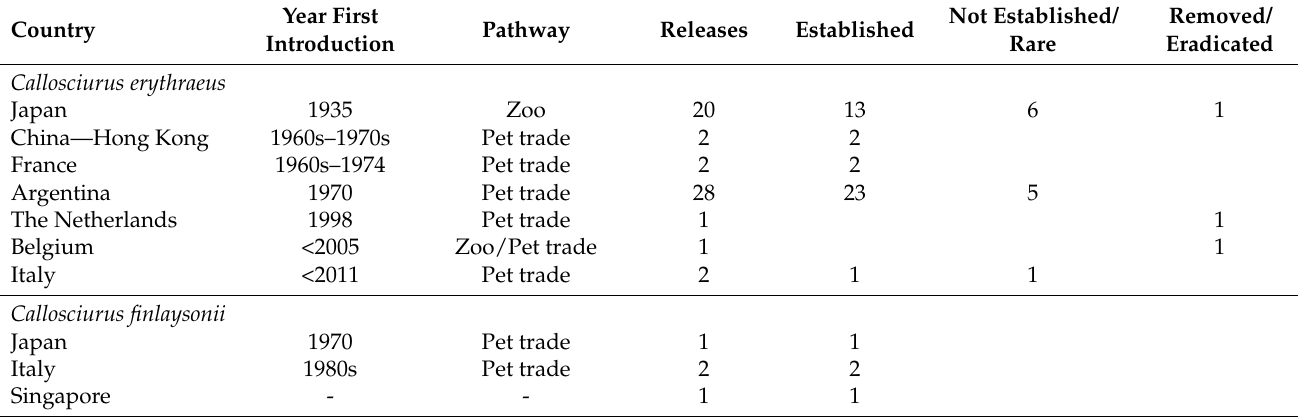
Table 1. Summary of the number of releases (introductions and translocations) of Callosciurus squirrels in the world.